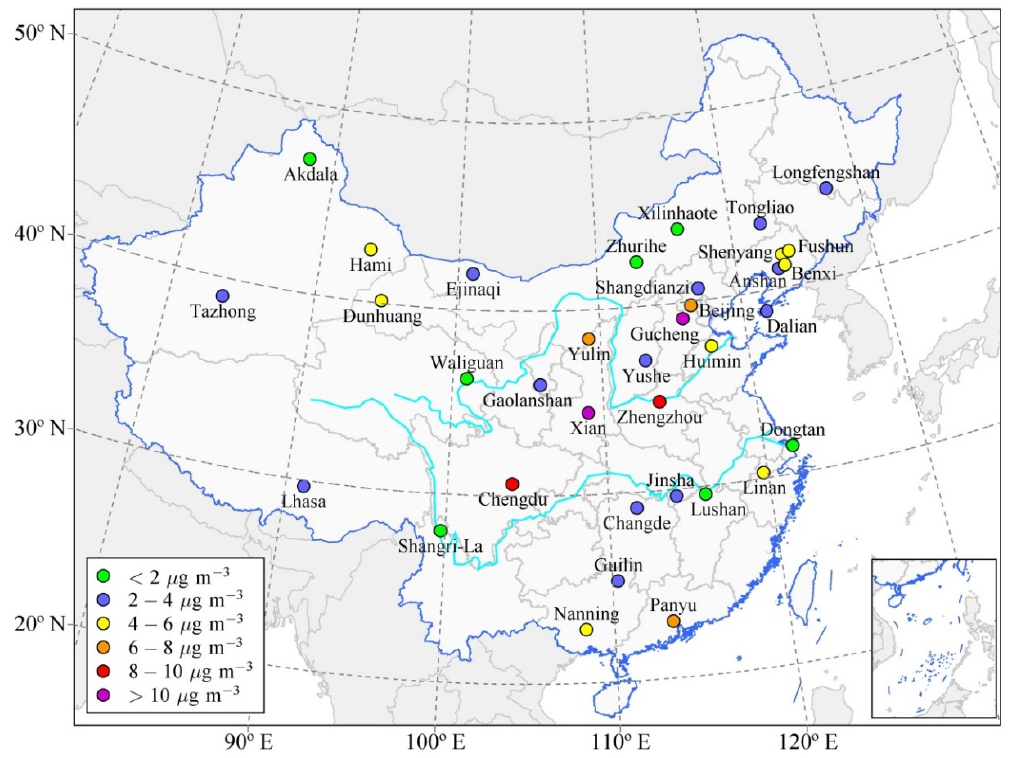
Figure 3. Average BC concentration of each site from 2006 to 2015, unit: μ g m − 3 .